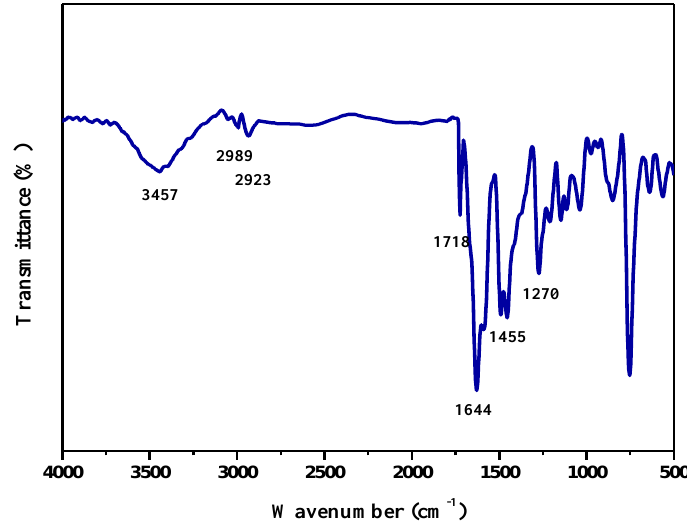
Figure 1. IR spectrum of Figure1. IR spectrum of MB-2.